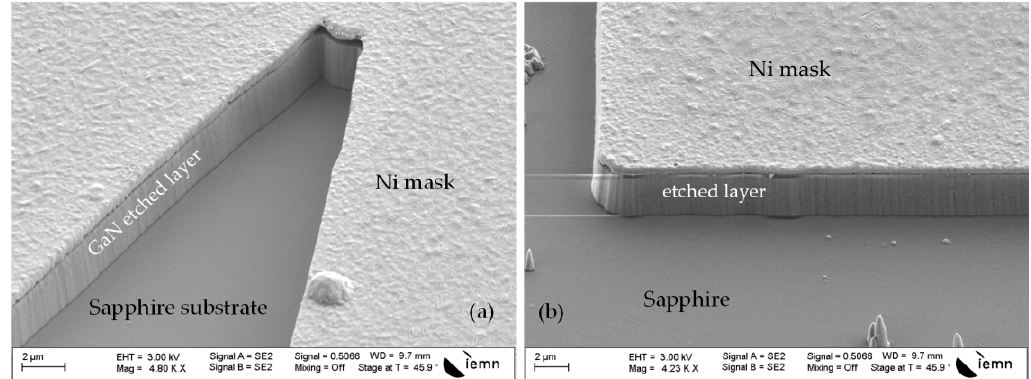
Figure 2. ( a ) Scanning electron microscope (SEM) analysis of mesa sidewalls after inductively coupled plasma (ICP) etching with sputtered nickel mask (depth of 3 µm for ICP power of 500 Watts. ( b ) Typical etching results showing Ni mask.